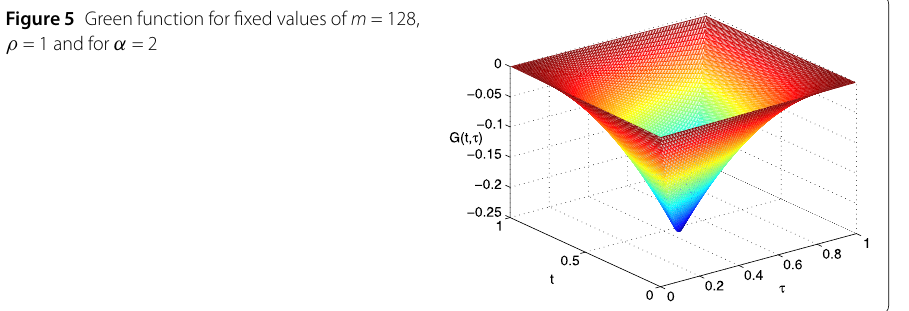
Figure 5 Green function for fixed values of m = 128, ρ = 1 and for α =